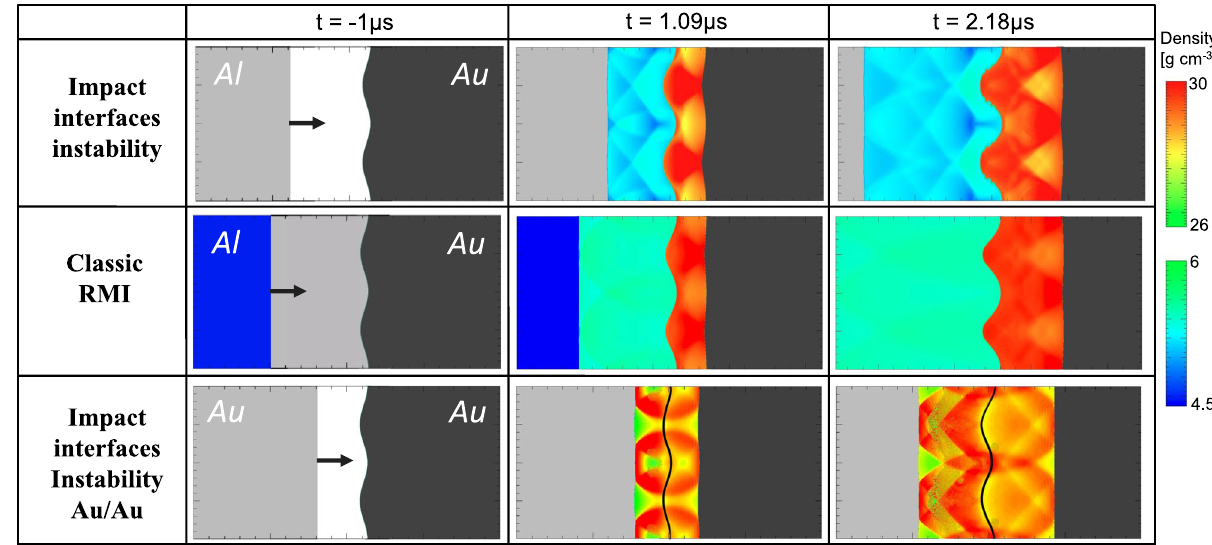
Fig. 3 Three cases of interface instability. Comparison between the interface instability following an impact in which the projectile or target has topography (top) and the classical Richtymer – Meshkov instability (RMI) for a shock transmitted through a corrugated interface (middle, shock moving from left to right), as simulated for aluminum and gold using the CTH code 9 . Two density ranges are plotted to highlight the wave interferences behind the shock fronts in the two materials (scales on right), with the dimensions being 4 cm in the direction of impact ( x ) and 2 cm in the orthogonal direction ( y ) (the calculation itself extends from − 15 to + 15 cm in the x -direction). In the present case of impact-induced instability, forward- and backward-propagating shocks are generated at t = 0 by collision of a fl at Al plate (gray: initial density) and a corrugated Au surface (black: initial density). Either medium can be impactor or target, due to symmetry discussed in the text. For the classical RMI, a shock generated up-range arrives at t = 0 at the wavy Al/Au interface, producing forward- and backward-propagating shocks. In both cases, the interface amplitude increases with time, indicative of a growing zone of mixing between impactor and projectile (Fig. 4). Light gray, black, and blue indicate densities of unshocked Al, unshocked Au, and (for classical RMI) initially shocked Al, respectively. The special case of impact between identical materials (Au/Au) is presented at the bottom (interface marked by a black line); there is no classical RMI analogy for this case involving identical projectile and target (Hugoniot relations), the shock pressure P and volume change Δ V are accompanied by a jump in material velocity normal to the